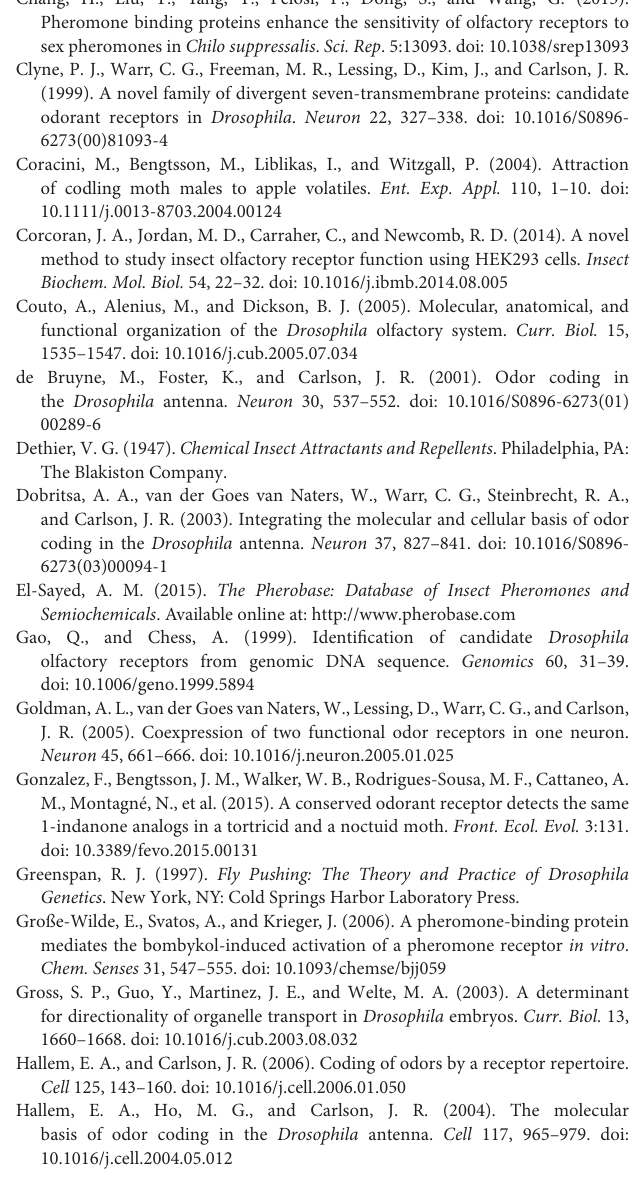
Supplemental Figure 1 | Timeframe for molecular cloning and generation of a transgenic fly line. Multiple ORs can be processed in parallel. Time for molecular work is a best-case scenario, assuming access to DNA sequencing of the generated plasmids. Timeline for obtaining transgenic flies after sending transformation/expression plasmids depends on micro-injection